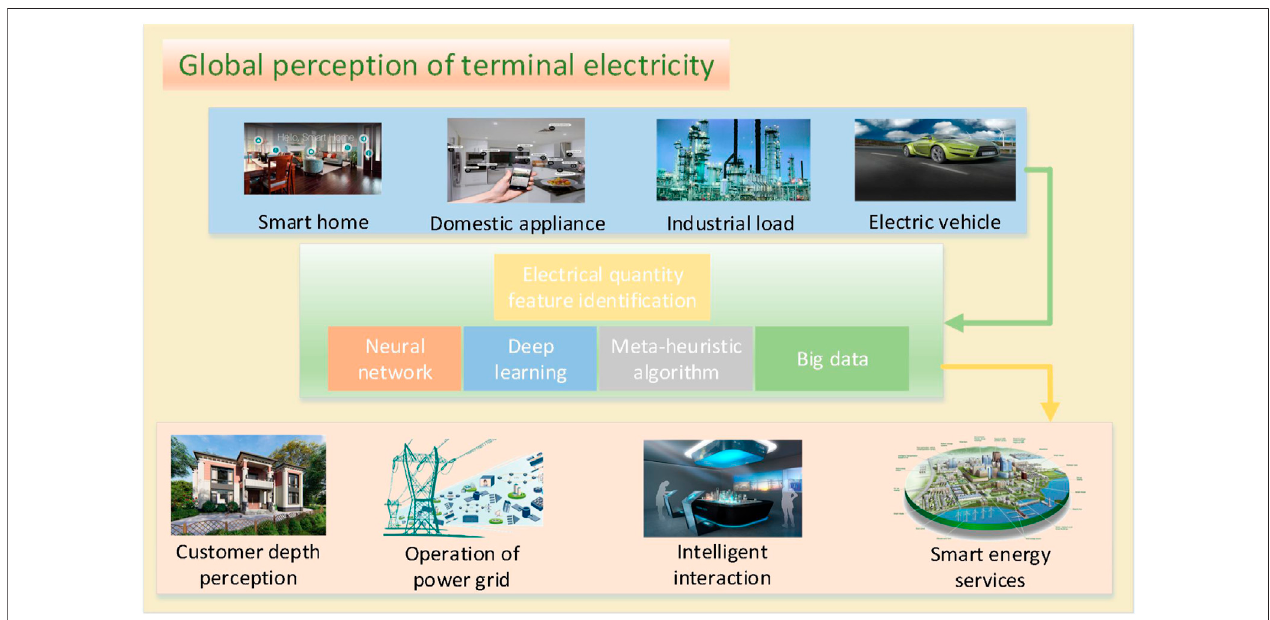
FIGURE 1 | Global perception diagram of terminal power